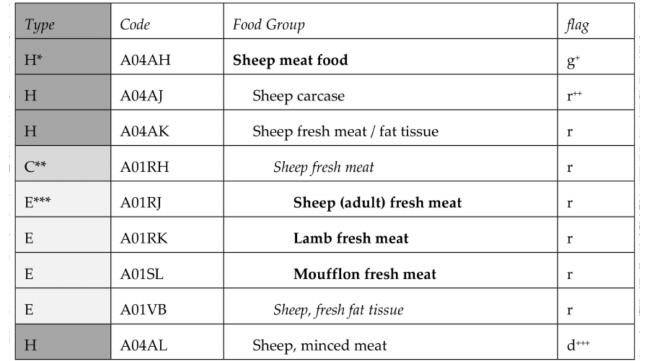
Figure 1. Example of FoodEx2 description and classification.* H—‘hierarchy term’; ** C—‘core term’;